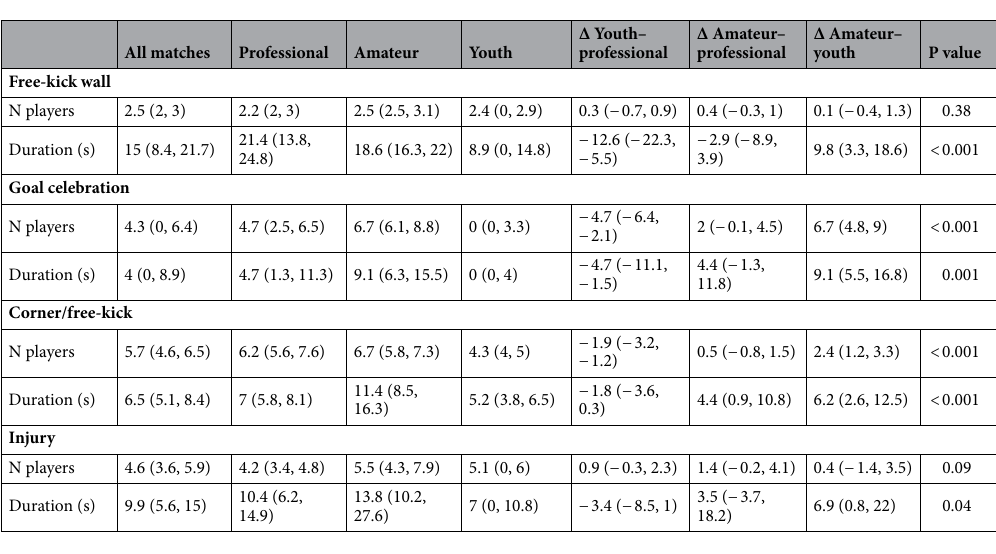
Table 3. Number of involved players and duration of crowding during breaks. Data for the different playing levels are presented as frequency per match-hour and as median with interquartile range. Differences between playing levels are displayed as medians with 95% confidence intervals. P values from Kruskal–Wallis test.